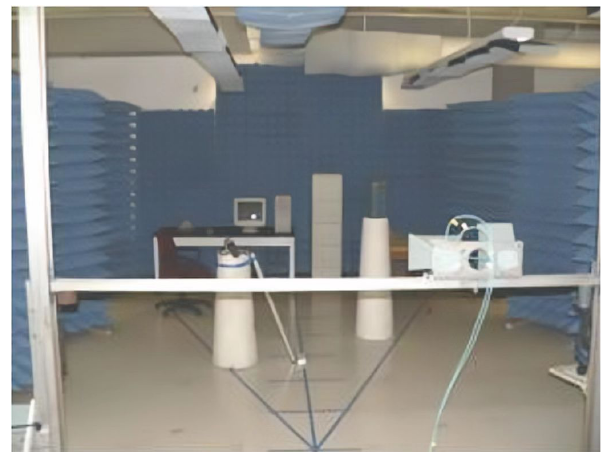
Figure 5. Experimental setup and room layout.